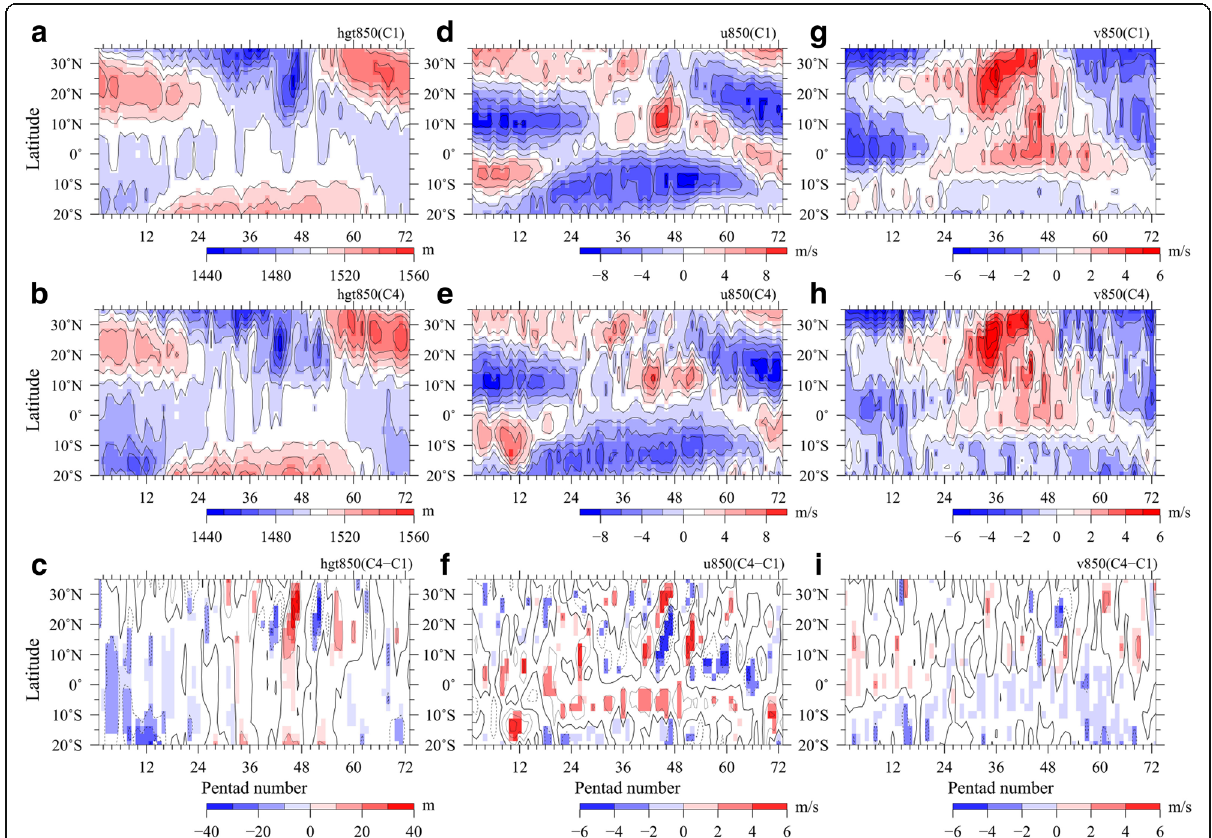
Fig. 7 Time-latitude cross section of the pentad mean geopotential height and zonal and meridional components of the wind fields at the 850 hPa level averaged for the years classified in C1 and C4. The figures in the left column indicate geopotential heights for C1 ( a ) and C4 ( b ) and the anomalies between C4 and C1 ( c ). The figures in the middle and right columns indicate zonal and meridional components of the wind field for C1 ( d , g ) and C4 ( e , h ) and the anomalies between C4 and C1 ( f , i ), respectively. The colored grids in c , f , and i indicate the significant anomalies at the two-sided 90% level according to Student ’ s t